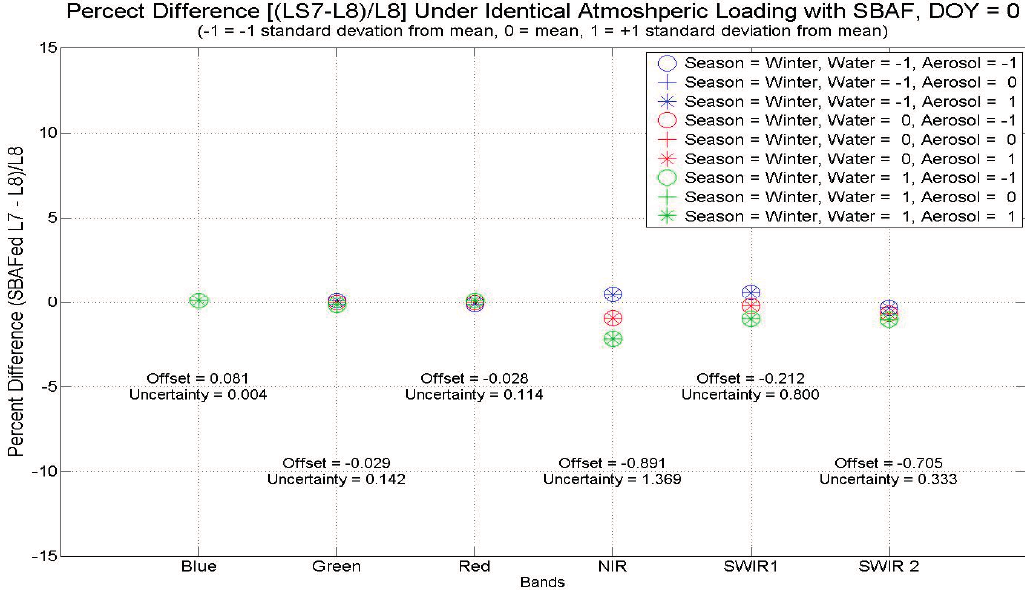
Figure 15. Percent difference between L7 and L8 coincident looks—Winter.